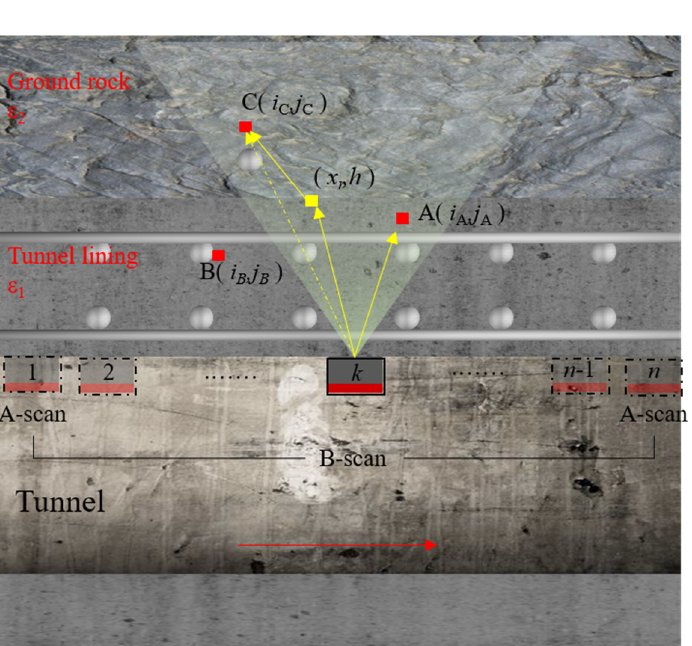
Figure 6. GPR detection process: equipment moves from A-scan1 to A-scank to acquire the information beneath the concrete segment (h is the thickness of the concrete segment, and ε is the dielectric constant).